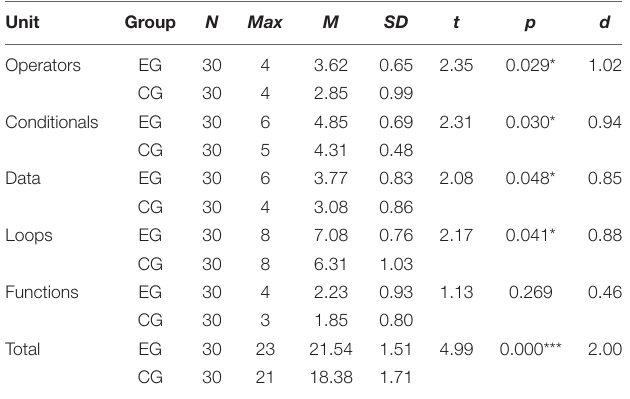
TABLE 8 | The independent sample t -test on the two groups’ computer-based final test.